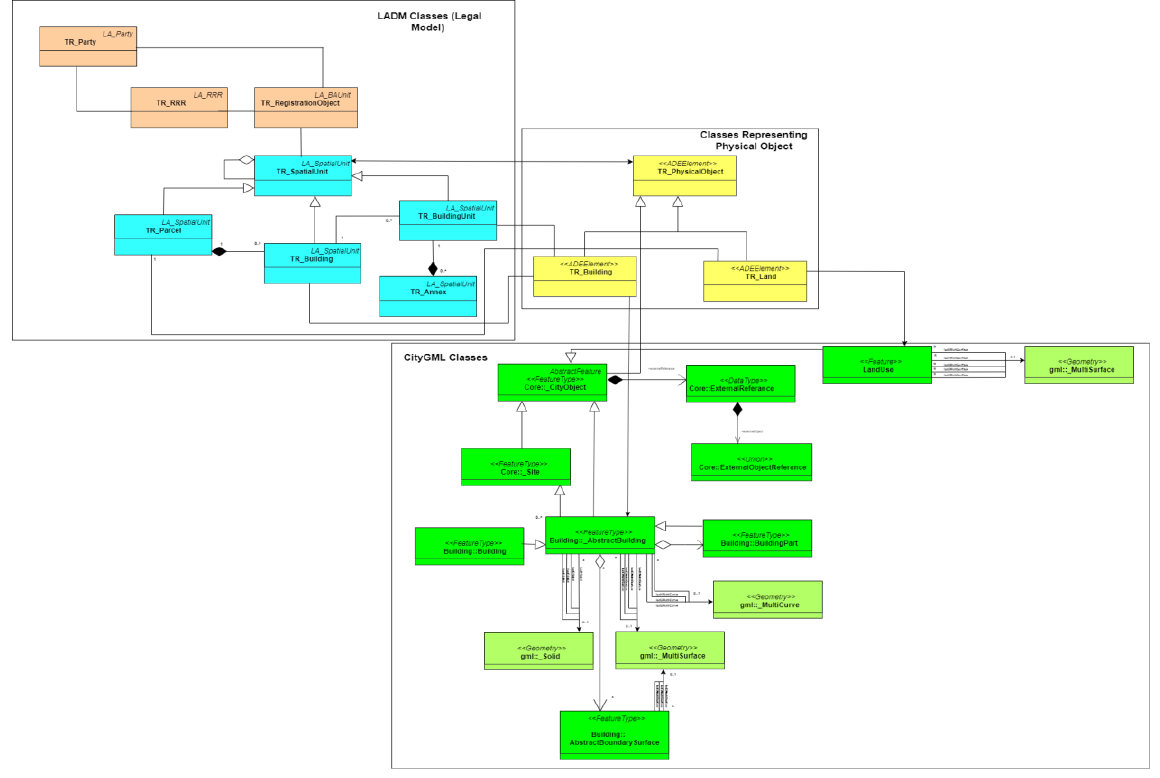
Figure 4. New proposed model for the Turkish cadastral system using, LADM and CityGML combining legal and physical